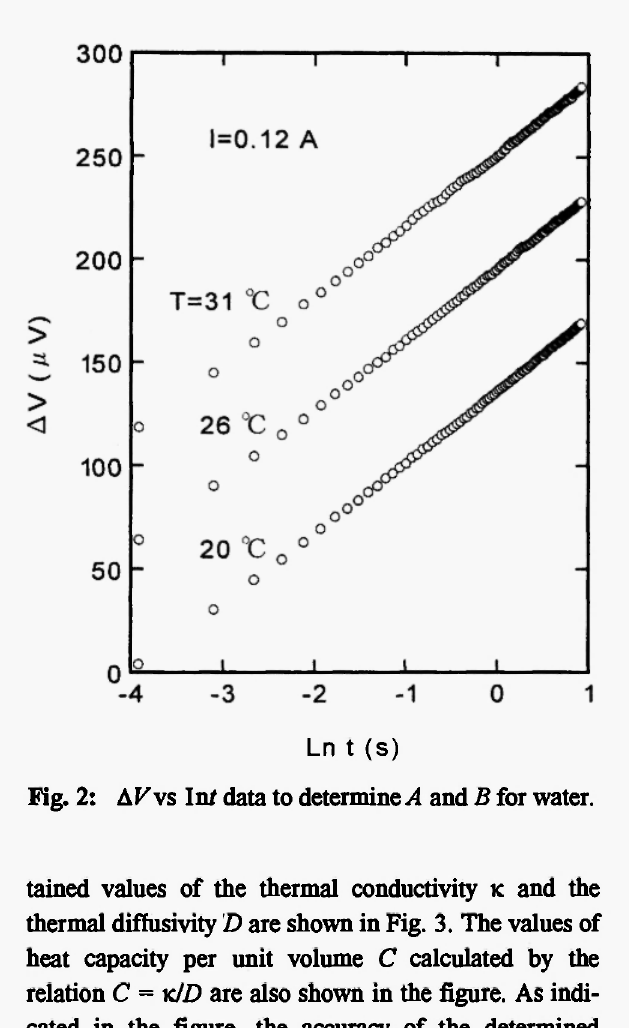
Fig. 2: AV vs In/ data to determine A and Β for